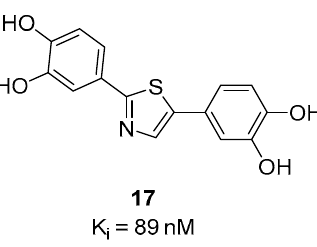
Figure 13. Chemical structure of 17 with binding affinity K i = 89 nM [106].